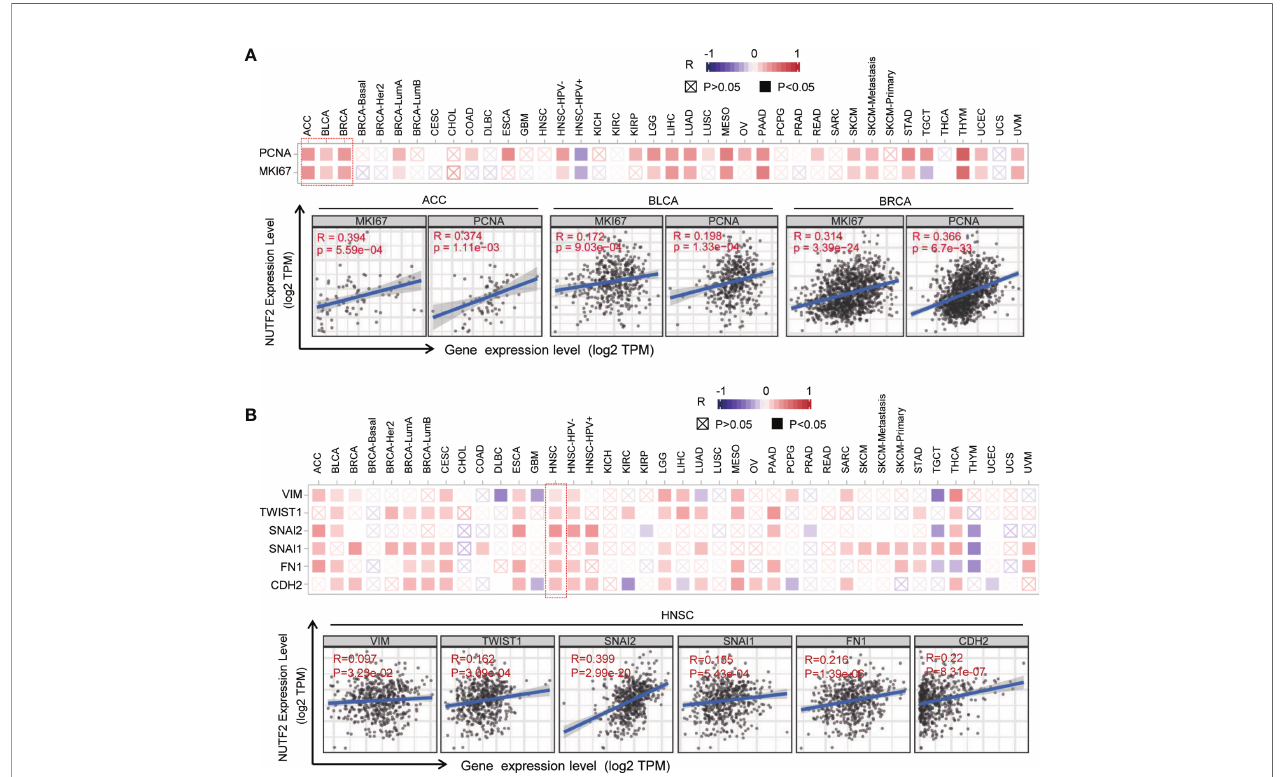
FIGURE 3 | Co-expression analysis between NUTF2 and biomarkers of cell proliferation and EMT markers. (A) Associations between NUTF2 expression level and proliferation markers (MKI67 and PCNA) were investigated in different cancer types. (B) Correlation analysis on the association between NUTF2 expression and EMT markers (Vimentin, TWIST1, Snail1, Snail2, Fibronectin 1, and